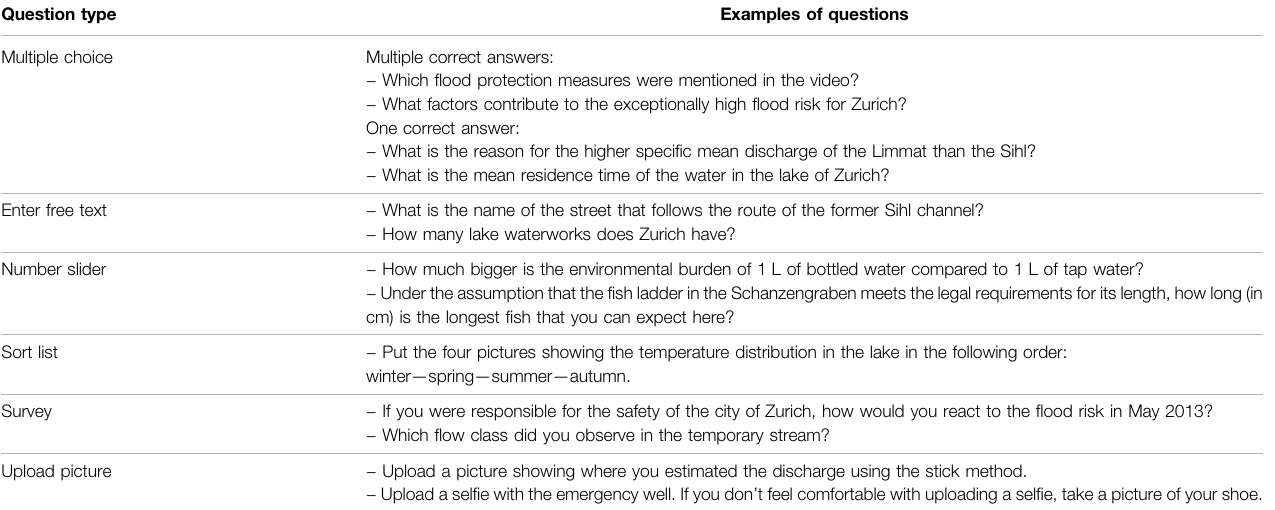
TABLE 3 | Question types and examples from the Water in the city of Zurich